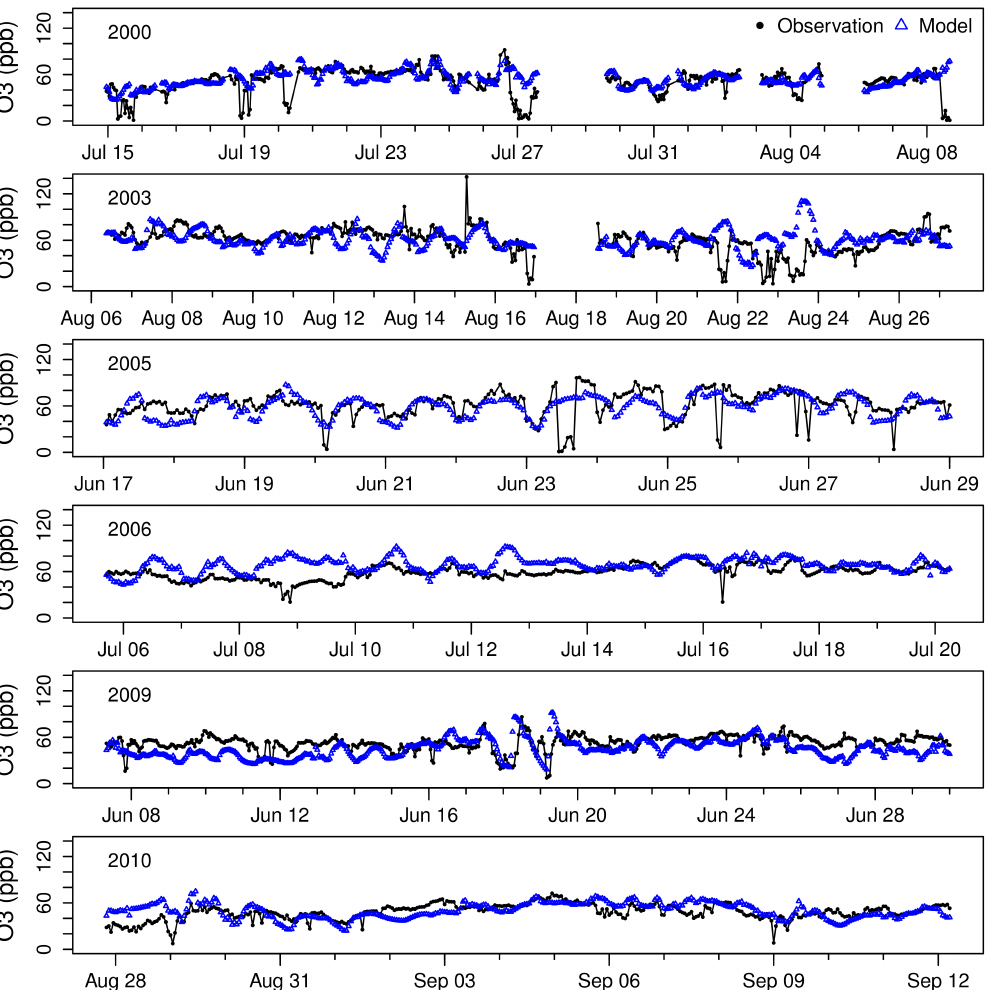
Measured and modeled O concentration ( ppb) during the oceanographic 3 campaigns (model values from the Em_hi